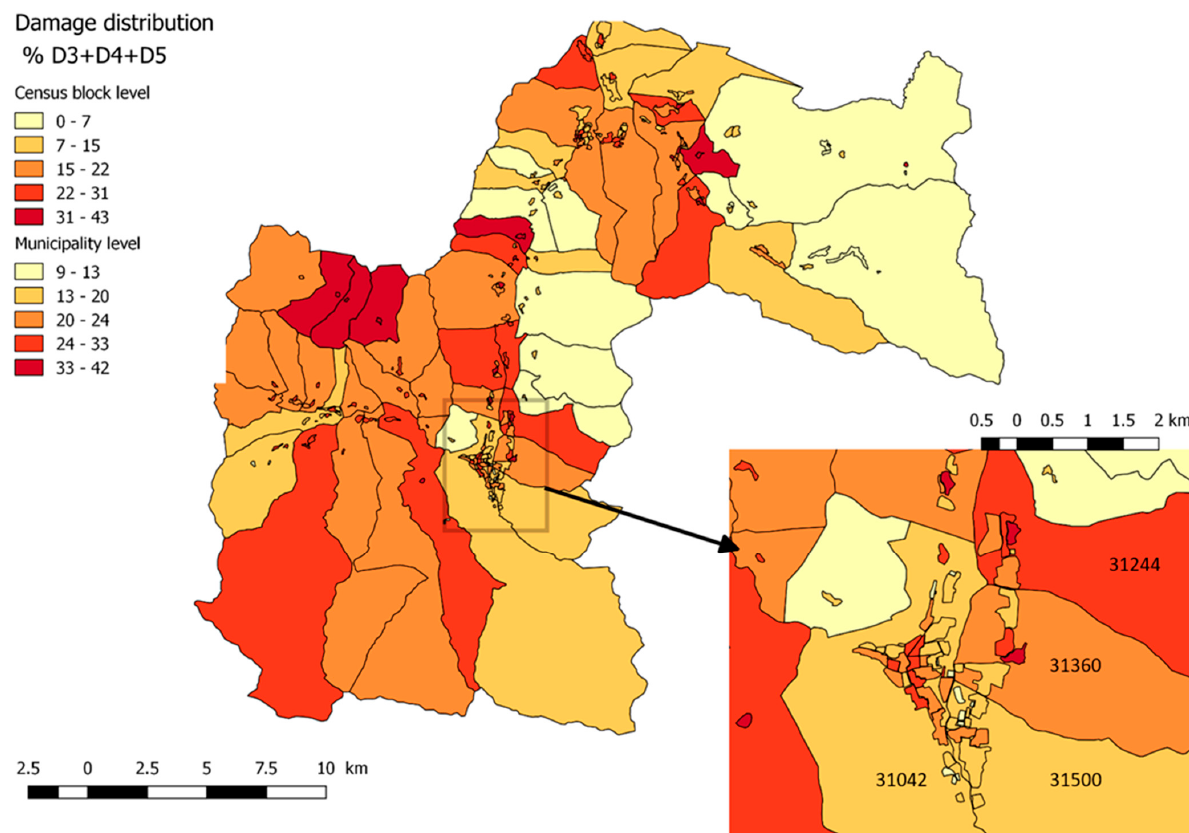
Figure 6. Percentage of damage degree superior to D3 for scenario SS3 for pga of 200 cm/s 2 amplified by the site effects: representation to the level of the municipality and to the infra-municipality level (homogeneous vulnerability census block).